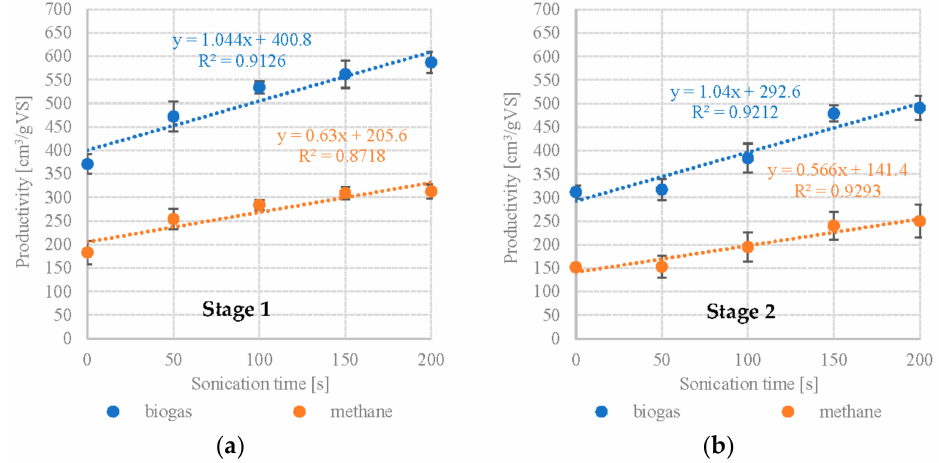
Figure 2. Correlations between UD exposure time and biogas/methane production ( a ) S1— Scenedesmus sp., ( b ) S2— Pinnularia sp. Table 2. Biogas and methane production. Variant Parameter Unit Scenedesmus sp. Pinnularia